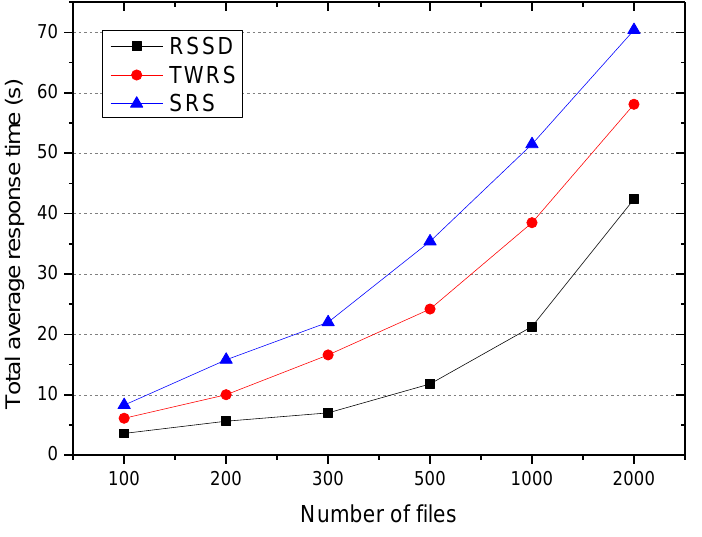
Figure 6. Total average response time.